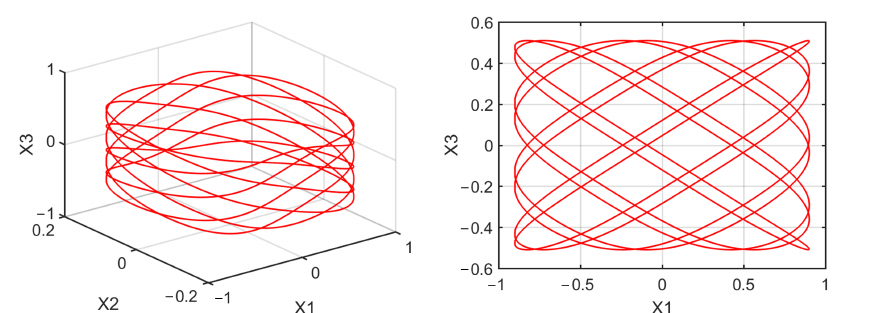
Figure A5. Periodic-7 motion of σ 2 = 5.7615.